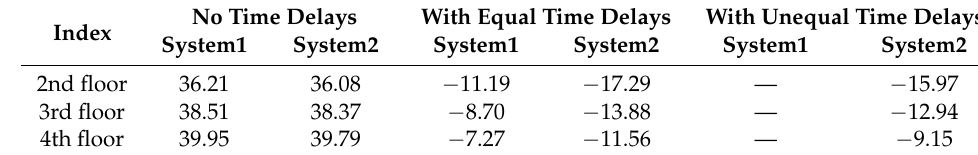
Figure 2. The experimental frame: ( a ) its picture and ( b ) its schematic diagram. Table 2. The acceleration control effects (%). Table 1. The important parameters of different AMD systems.